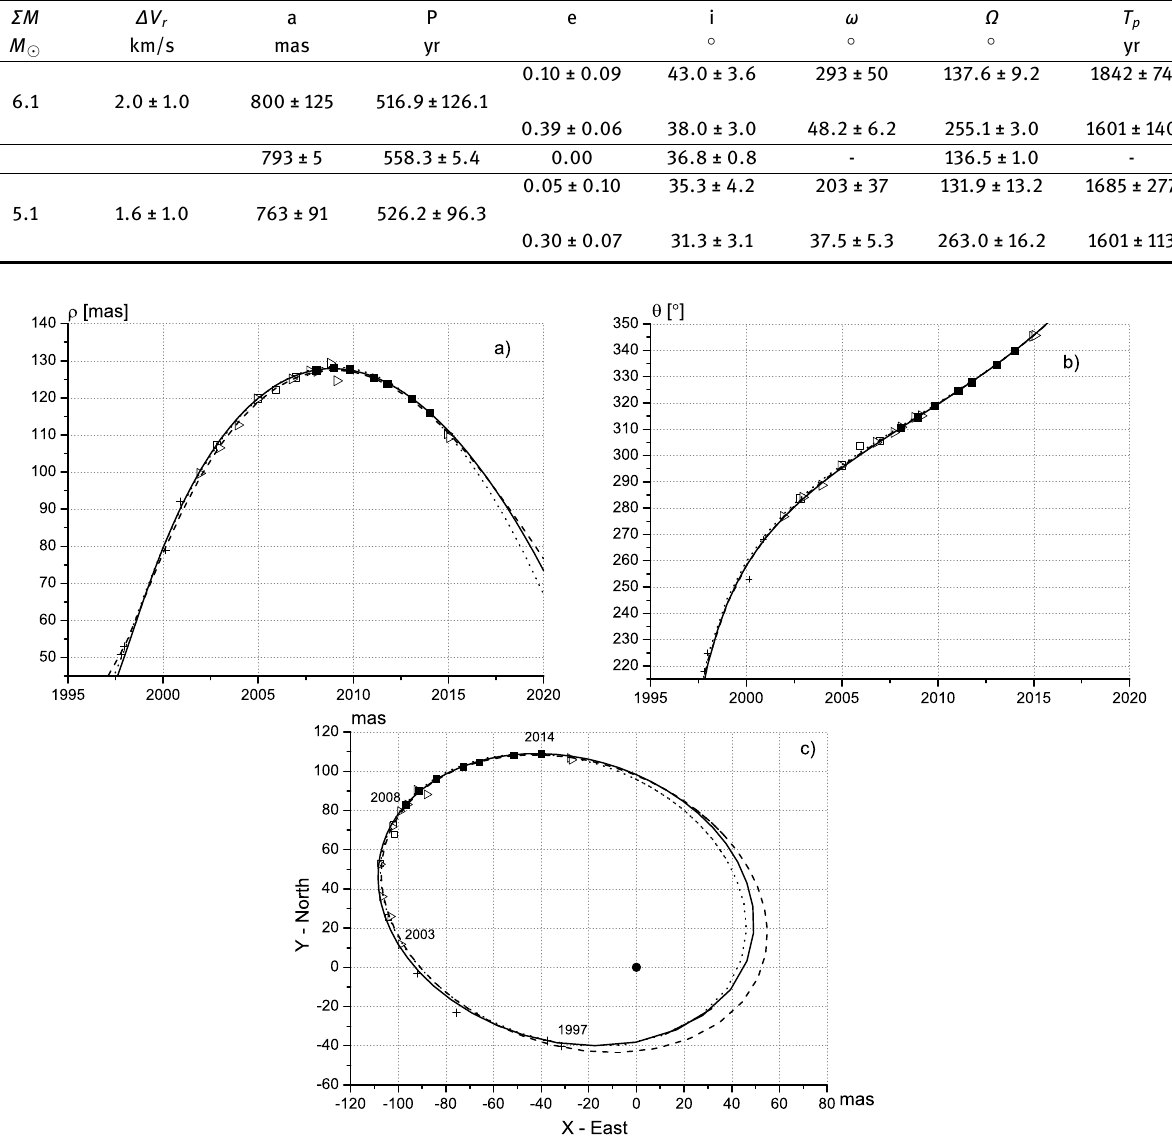
Fig. 5. T Tauri SaSb orbits. Comparing with observations: ρ ( t ) (a), θ ( t ) (b), y ( x ) (c). Observations of the KeckII are denoted by squares, obser- vations of the VLT — by triangles, other WDS observations — by crosses, coordinates of the main arc for AMP determinations are denoted by black squares. Lines are ephemeris of the orbits: the orbit of this work (solid line); the Shaeffer’s orbit (dash line), the Koehler’s orbit (dot